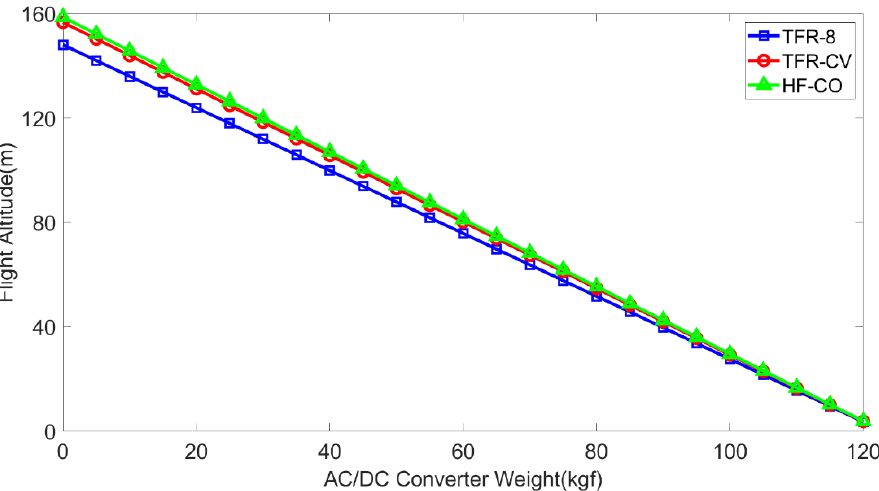
Figure 4. Maximum flight altitude of the tethered multicopter for various types of power cable according to the weight of AD/DC converter.